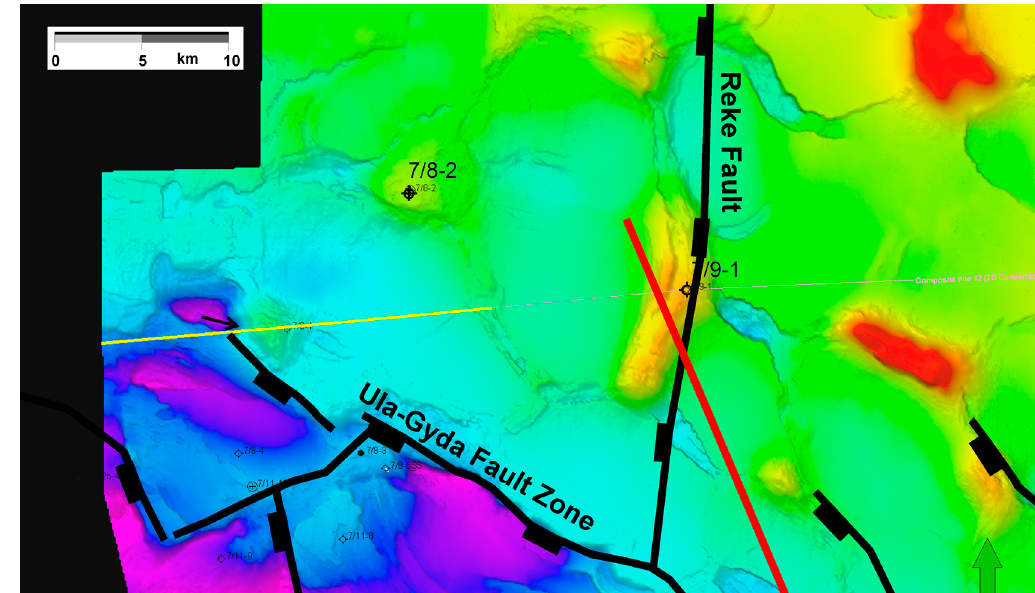
Figure 6. Base Cretaceous (BCU) time map provided by Lotos showing Cretaceous collapse grabens North of the Ula Fault. The Triassic sag-basins or pods are the polygonal flat areas between positive salt-structures and supra-salt collapse grabens. The arrows indicate the direction of salt movement away from the collapsing grabens accumulating into the growing salt diapirs. Red colors define the shallowest areas, and purple defines the deepest areas. Red line shows the Northern part of Model 2.